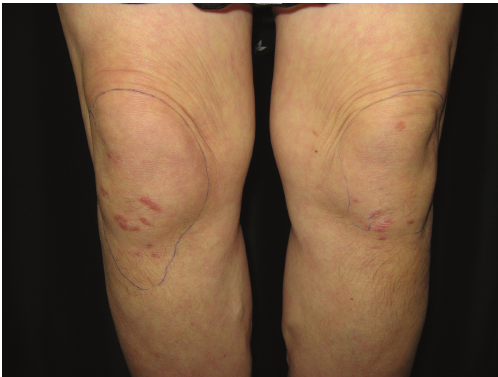
Figure 1: Raised, brawny red nodules of the elbow. Figure 2: Raised, brawny red nodules of the knee. The outline indicates the range of subcutaneous nodules.